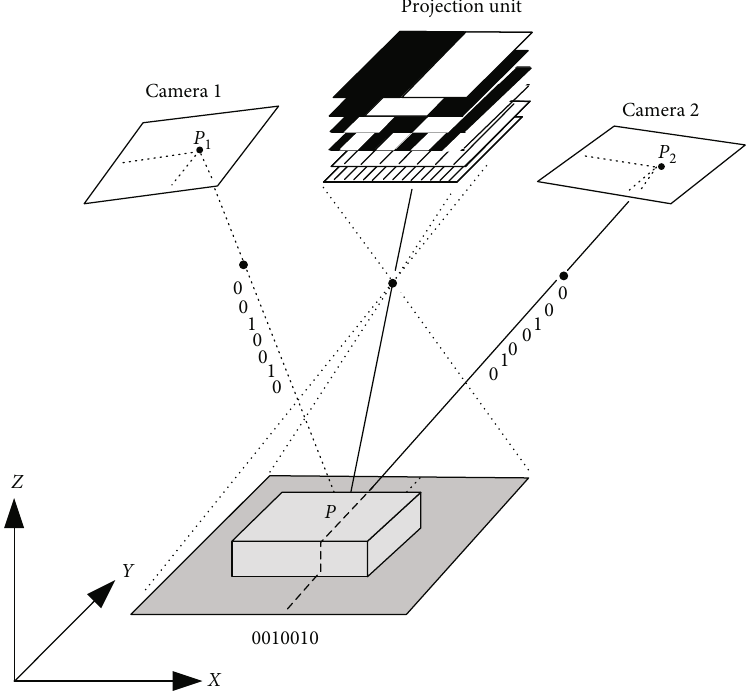
Figure 3: Principle of the advanced topometric sensor system